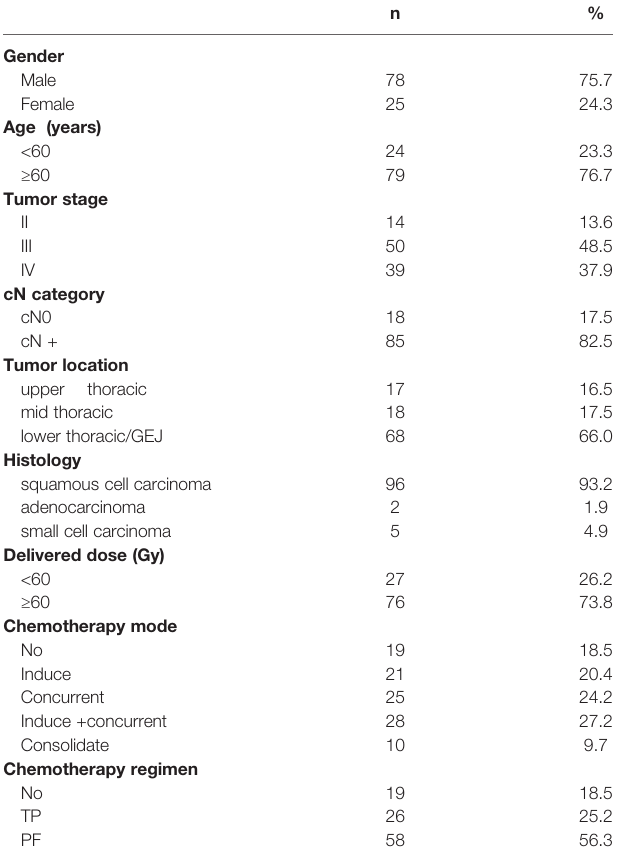
TABLE 1 | Patient